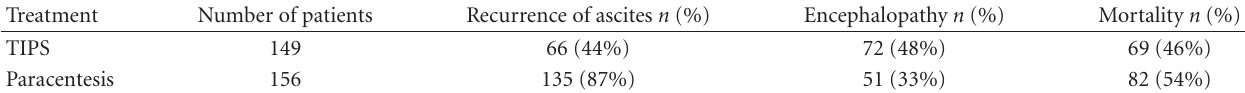
Table 6: Comparison of TIPS and large volume paracentesis in the treatment of refractory ascites (from D’Amico et al. [96]).